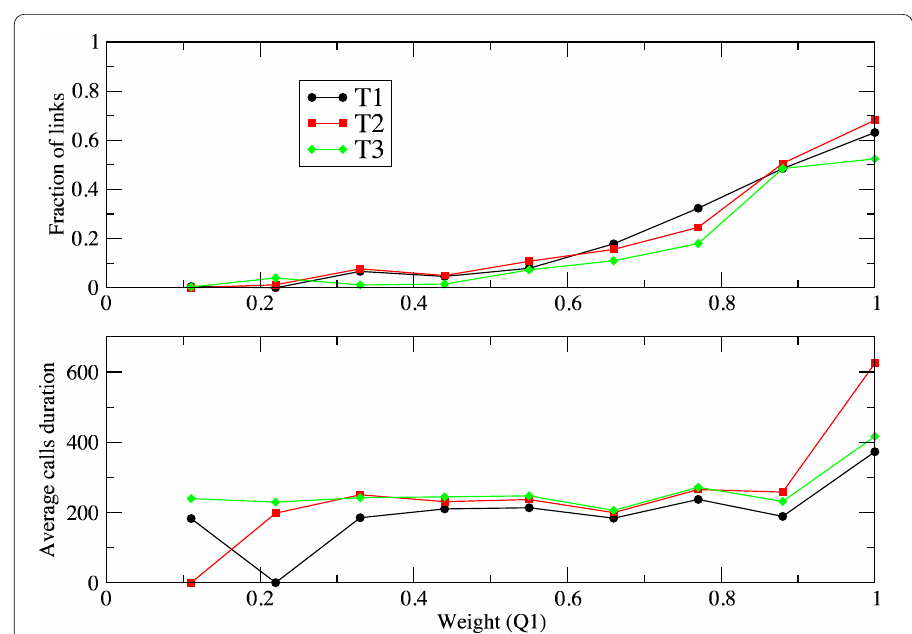
Figure 6 Communication between individuals as a function of friendship. Top plot: fraction of links corresponding to a communication as a function of their weight in Q1. Bottom plot: average aggregated duration of communication along a link (i.e., weight of the link in the communication network) as a function of its weight in Q1